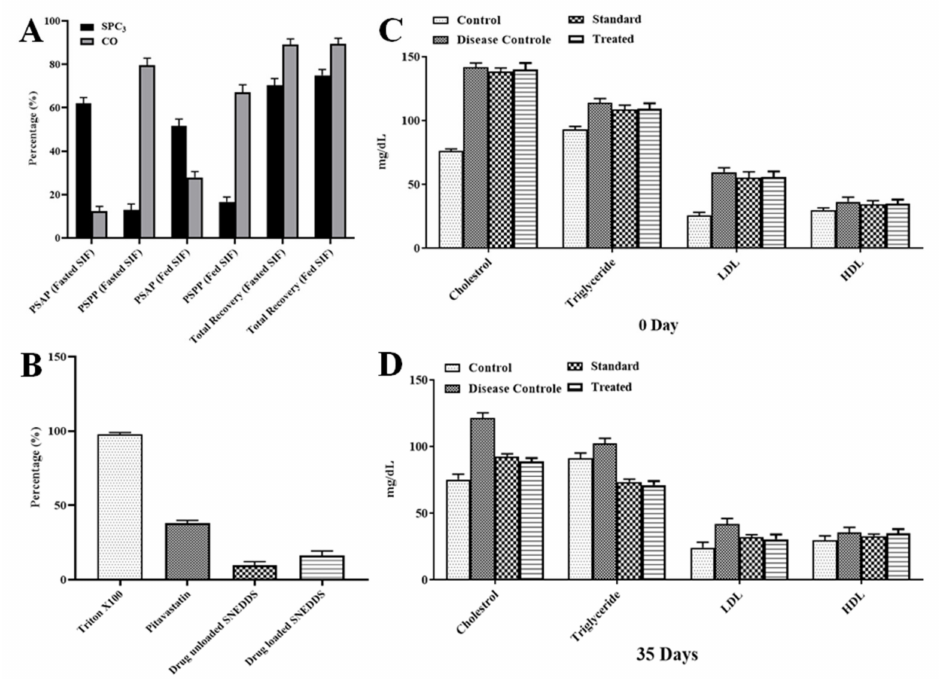
Figure 6. In vitro lipolysis ( A ), RBC lysis ( B ) and lipid profile of albino rats at 0 ( C ) and 35 days ( D ). CO, is cinnamon oil (pitavastatin in oil); PSAF, pitavastatin in aqueous phase; PSPP, pitavastatin in pellet phase; SIF, simulated intestinal fluid; LDL, low-density lipoprotein; HDL, high-density